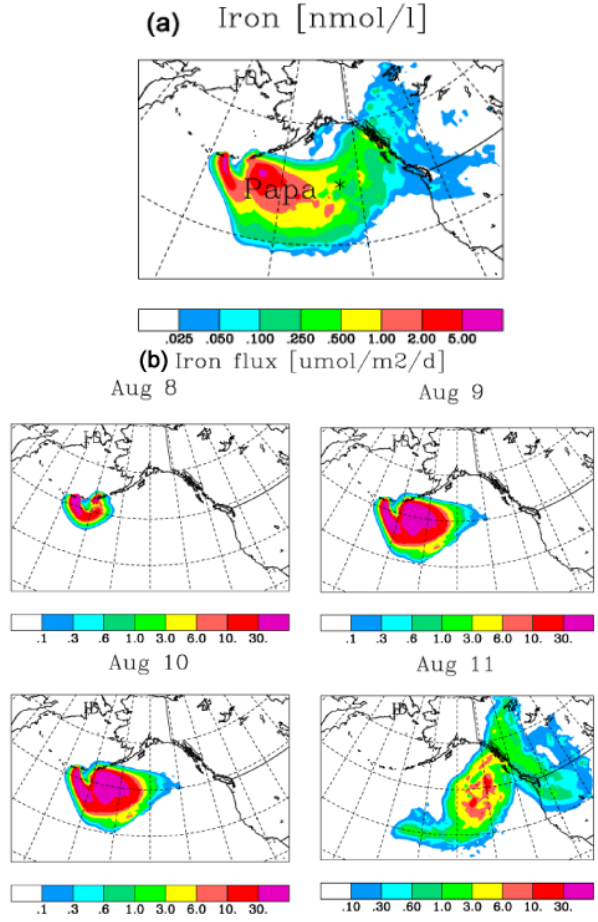
Fig. 3. (a) Modelled maximum available ocean mixed layer iron concentration after the eruption of Kasatochi in the NE Pacific Ocean from 8–15 August 2008 [nmolL − 1 ] and (b) modelled daily fluxes of volcanic ash to the NE Pacific Ocean [µmolFem − 2 d − 1 ]. The location of station Papa is indicated in (a)